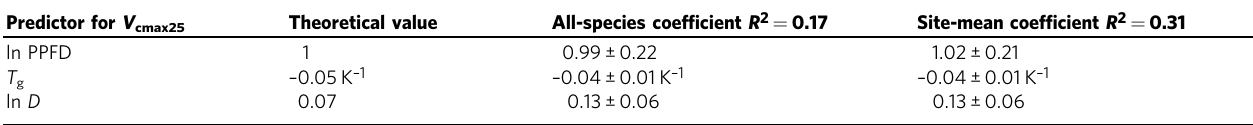
Table 1 Summary statistics for the climatic dependencies of V cmax25 ( μ mol m – 2 s – 1 ). Predictor for V